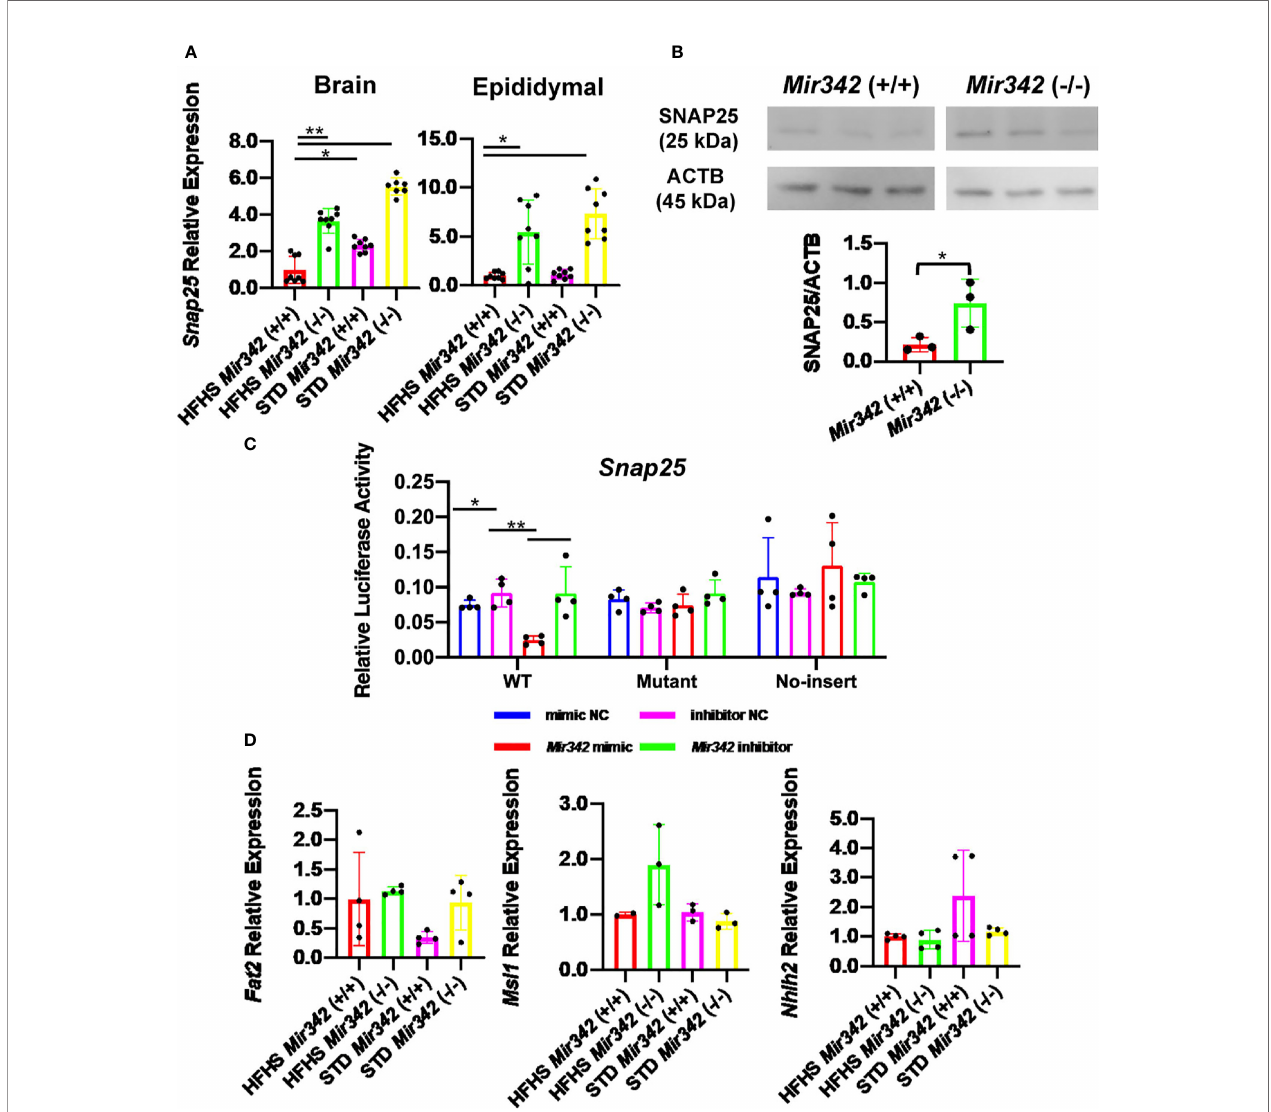
FIGURE 6 | The expression and reporter assay of Snap25 (synaptosomal-associated protein, 25kDa). (A) Relative mRNA expression of Snap25 normalized by Rplp0 and Rn18s in brain and epididymal fat tissues detected by RT-qPCR. (B) Western blot analyses and quanti fi cation of SNAP25 protein levels in hypothalamus. (C) Dual-luciferase reporter assay. pmirGLO-Snap25 WT 3 ’ -UTR, pmirGLO-Snap25 MT 3 ’ -UTR, and pmirGLO no-insert control plasmids were cotransfected with Mir342 mimic, Mir342 inhibitor, negative control siRNA (mimic NC), inhibitor negative control (inhibitor NC) into HEK293T cells, respectively. (D) The expression of predicted target genes (Fat2, Msi1 and Nhlh2) in brain. Data are analyzed by independent t-test or one-way ANOVA with a Tukey test. All data are presented as mean ± SD (*p < 0.05; **p <